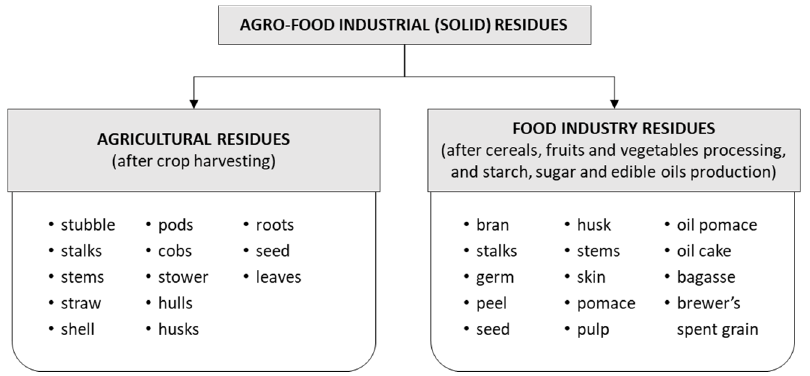
Figure 1. Classification of